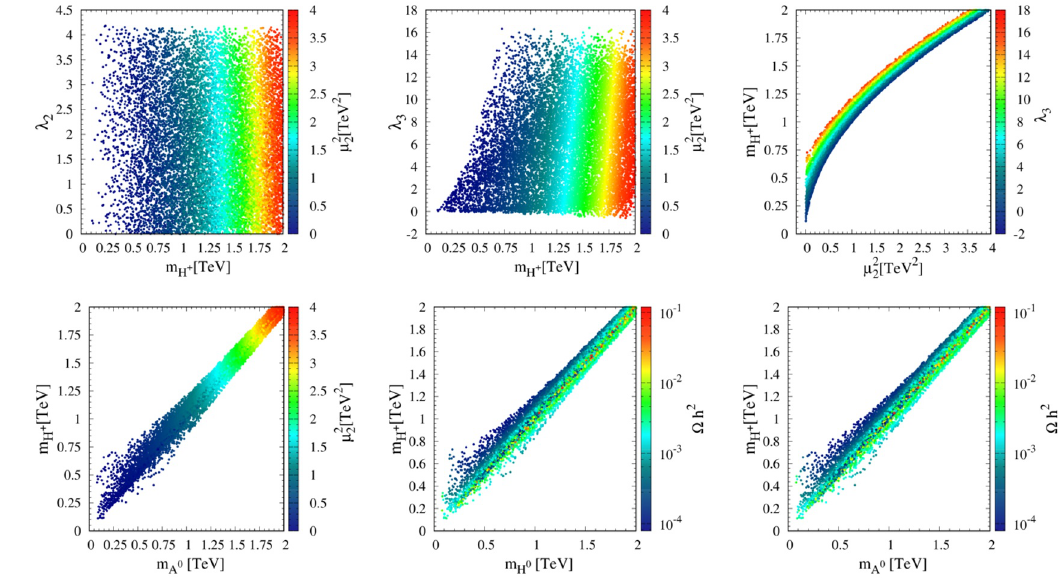
Figure 4 . Allowed parameter space in the non-degenerate IHDM spectra using all theoretical and experimental constraints are shown, which correspond to Scenario III defined in table 2.